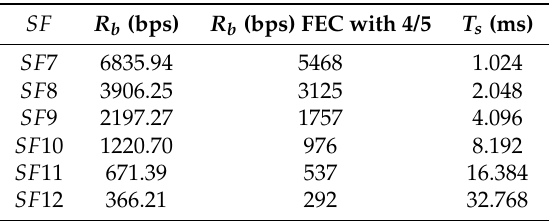
Table 1. Data rate according to the SF